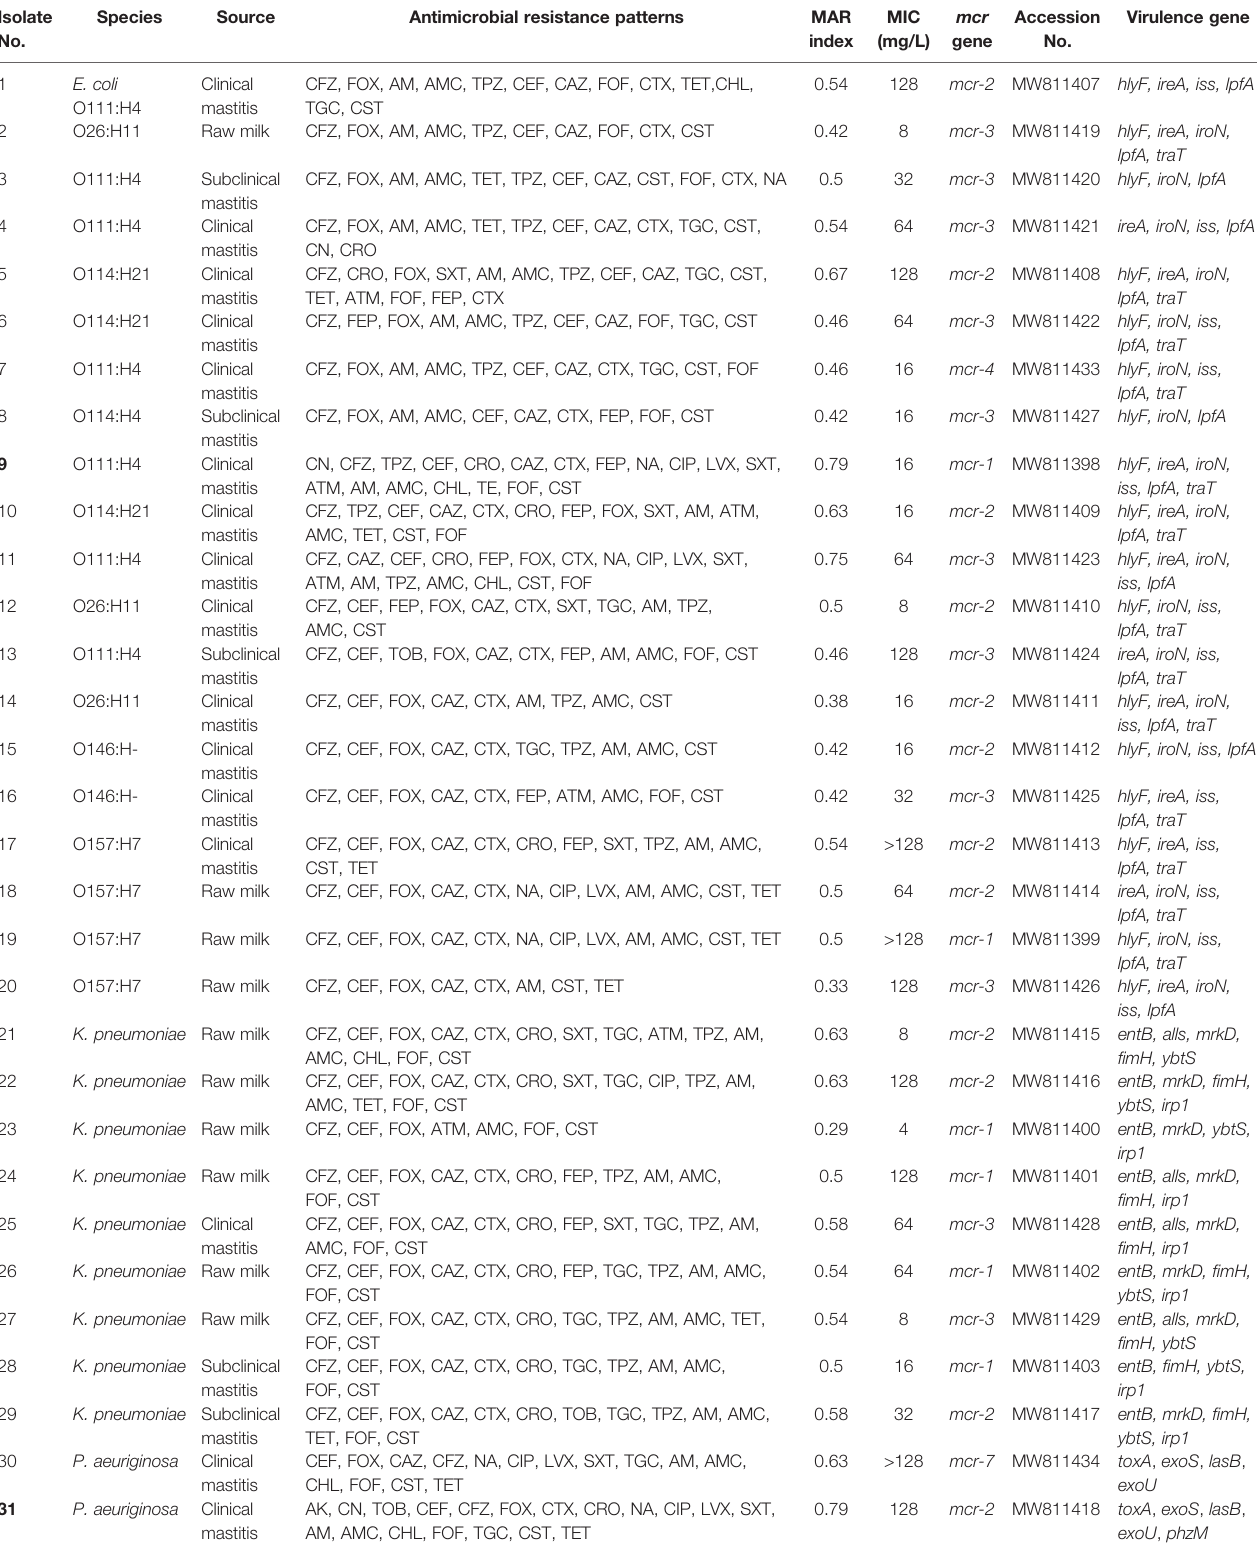
TABLE 2 | Resistance phenotypes, virulence genes pro fi les, and plasmid-mediated mcr genes of 47 Gram-negative bacteria recovered from milk samples. Isolate No.